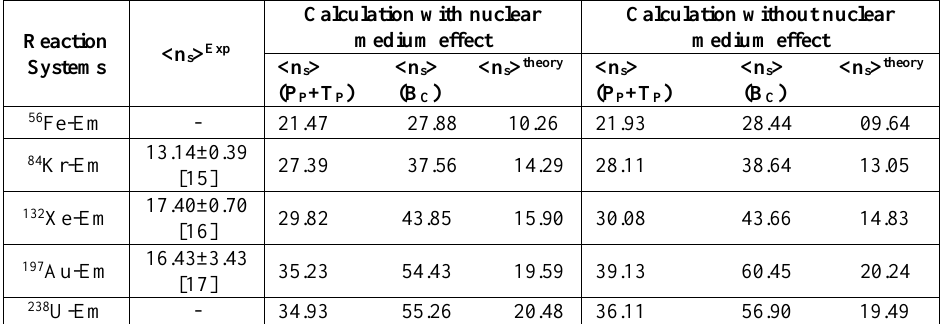
Table 1. The calculated average values of the shower particle multiplicities (N S ) in framework of the CMGM model and corresponding experimental data are